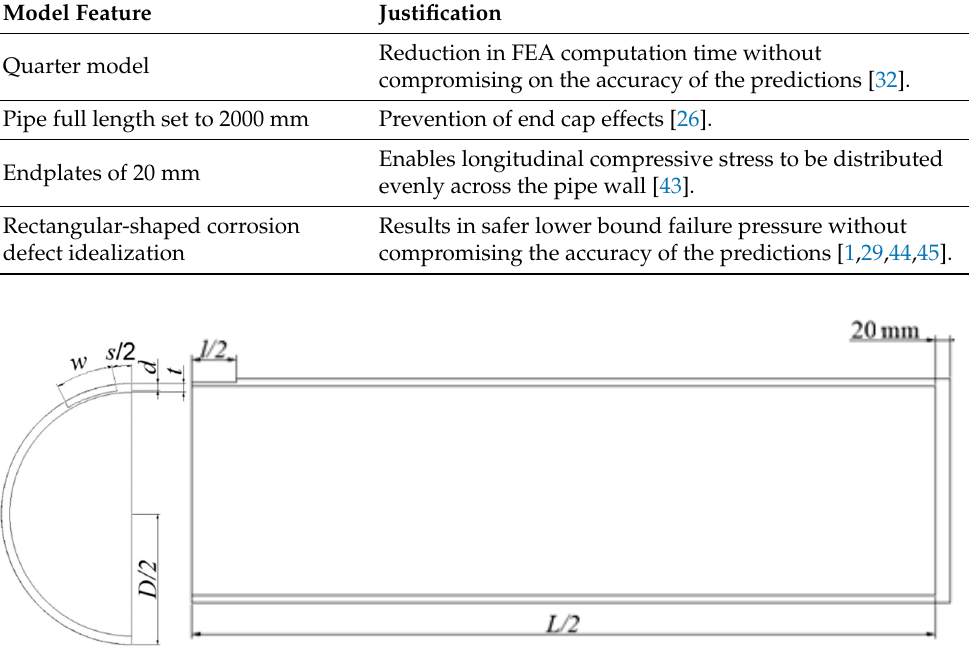
Figure 3. A quarter pipe model of a pipe with circumferential interacting corrosion defects. The quarter models were meshed with solid elements due to the thickness of the pipe wall. The pipe body and defect region were meshed using hexahedral SOLID185 compo- nents, while the rigid body was meshed using tetrahedral SOLID186 elements. SOLID185 is characterised by eight nodes with three degrees of freedom, whereas SOLID186 can accommodate curved boundaries (irregular shapes). Both elements accommodate creep- ing, high stress stiffening, plasticity, significant deflection, swelling, and high strain [46]. According to the British Standards Institution (BSI) recommendations, the defect zone number of layers was set to three with a length and depth of 2 mm [47]. A conver- gence test was performed prior to finalising these mesh settings to achieve the least pos- sible computation cost loss of accuracy. The convergence test results are summarised in Table 4. Based on the results, the optimal number of mesh layers in the defect region was determined to be three. Table 4. Convergence test results for the optimal number of mesh layers at the defect region for Test Model 1. Number of Element Layers